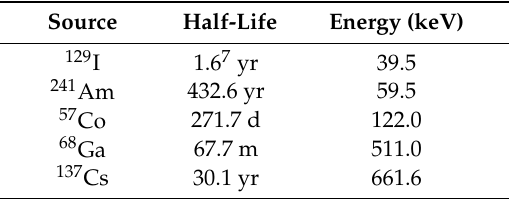
Table 2. Physical characteristics of the radioactive sources used for NaI(Tl) detector energy response measurements